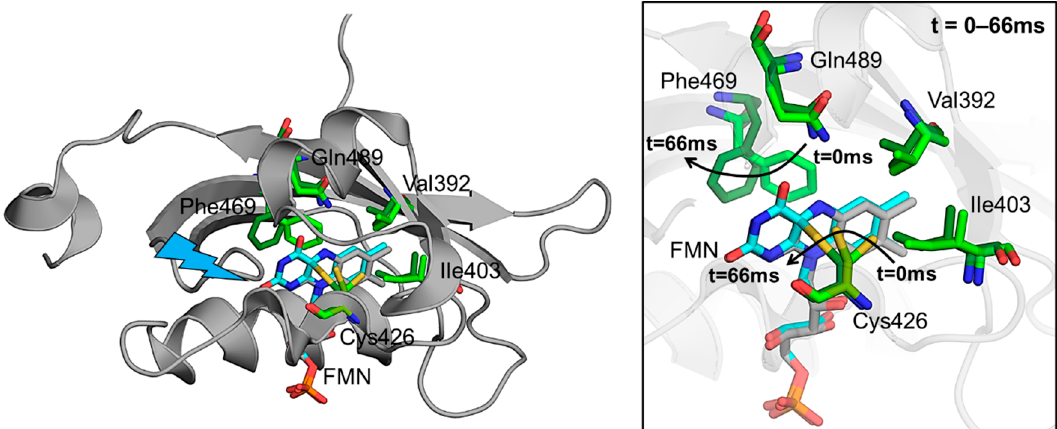
Figure 4. TR-SSX for the LOV2 domain of phototropin-2. ( Left ) Cartoon representation of the LOV2 domain. Key residues and the FMN chromophore at the catalytic site are highlighted as sticks representation. ( Right ) Closer view of catalytic site. The black arrows illustrate the changes occurring at time point 66 ms upon light illumination. Major changes occur for Cys426 and Phe469 (light green represents t = 0 s and dark green t = 66 ms). The FMN chromophore is shown as gray cartoon for t = 0 s and cyan for t = 66 ms.